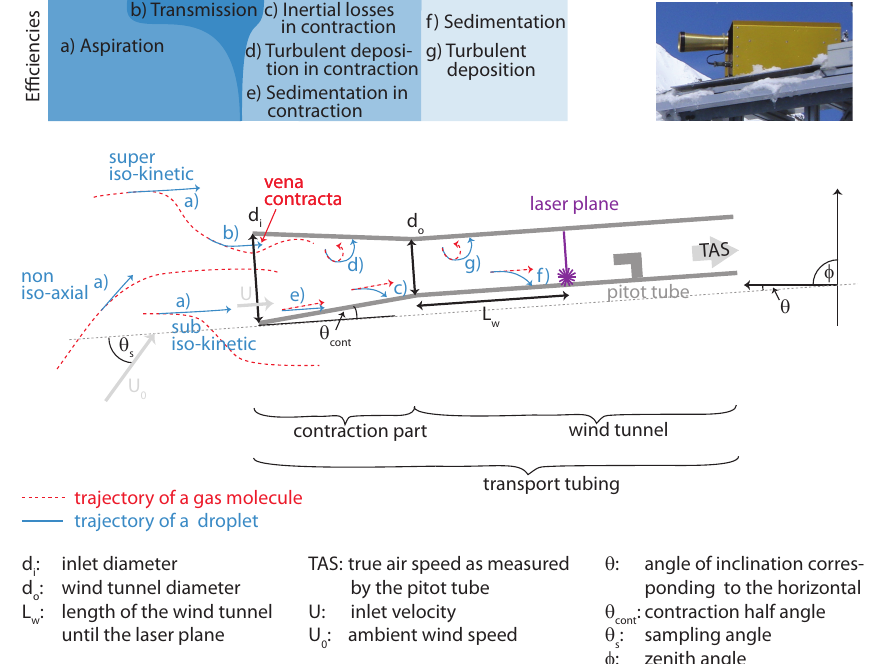
Fig. 5. Illustration of the different particle loss mechanisms – (a) to (g) – as described in Sect. 3.2 for the FM-100 (the small photograph shows the FM-100 at Jungfraujoch). Values for the FM-100 geometry are given in Table 1. Detailed description of the formulas of the particle loss mechanisms are given in Appendix